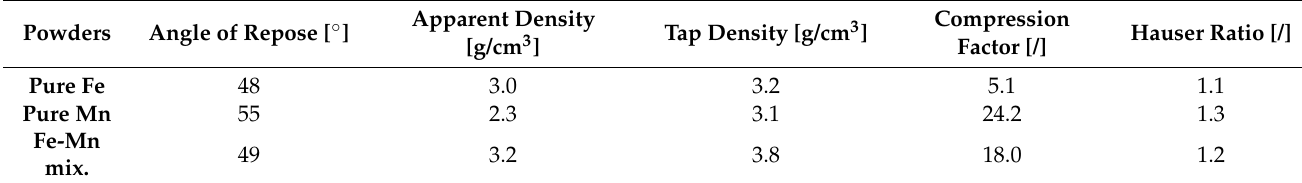
Table 3. Properties of metal powders.